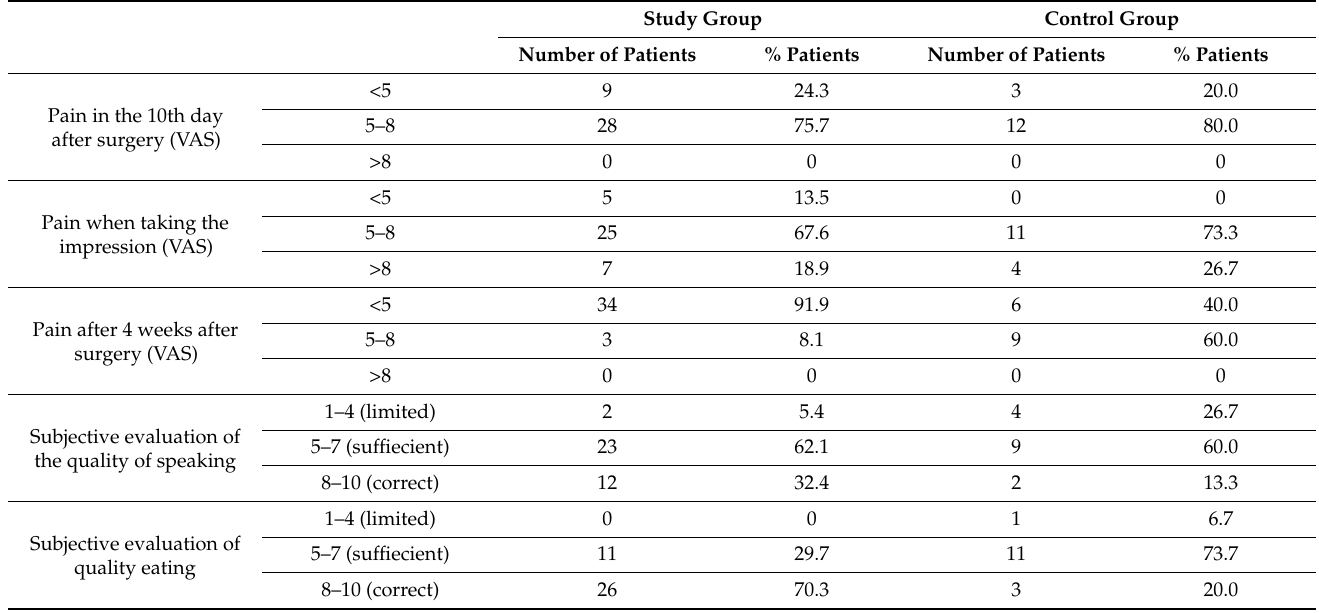
Table 3. Assessment of patient’s